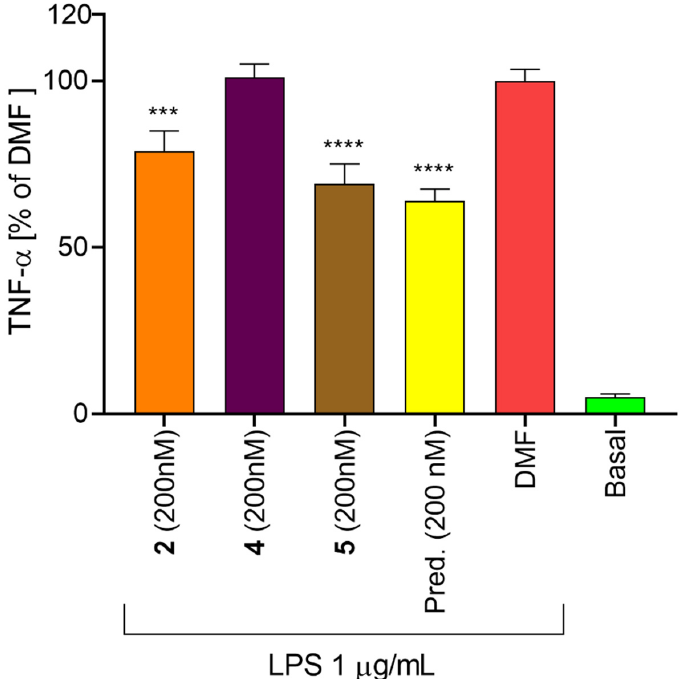
Figure 8. The effect of complexes 2 , 4 and 5 on the secretion of TNF- α . THP-1 cells were differentiated to macrophages by PMA. Such cells were pre-treated by complexes 2, 4, and 5 (200 nM) or prednisone (200 nM) for 1 h, then LPS (1 µ g/mL) was added to trigger the inflammatory signalization. Cultivation medium was collected 24 h after LPS stimulation and the amount of TNF- α was determined by ELISA technique. Graph represents mean ± SEM. *** indicates statistical significance ( p ≤ 0.001) to 0.1% DMF-treated group. **** indicates statistical significance ( p ≤ 0.0001) to 0.1% DMF-treated group.